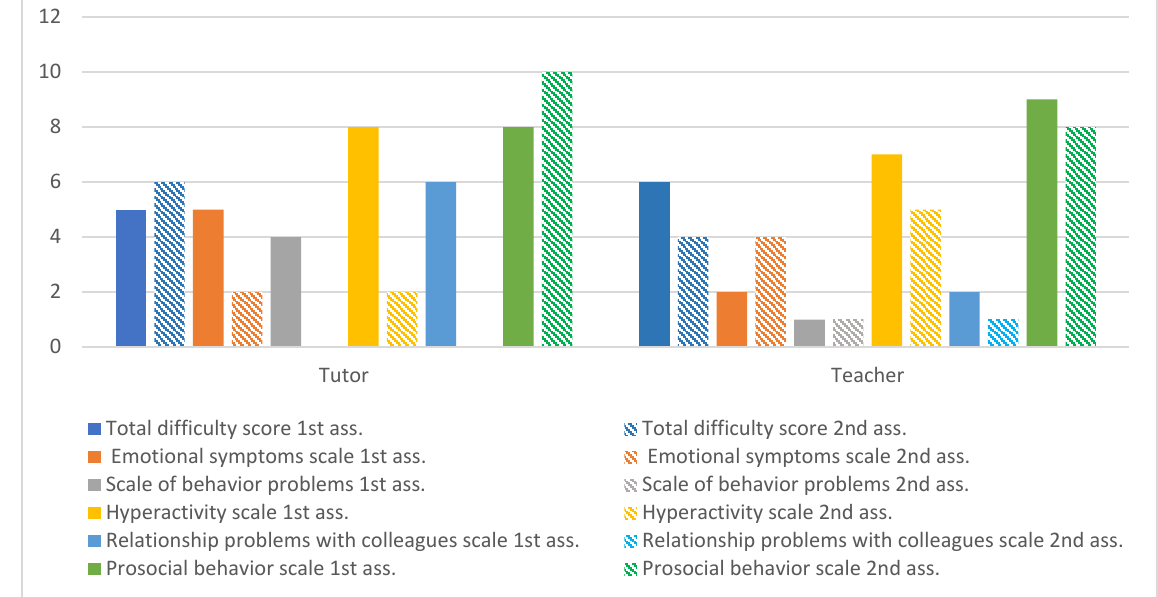
Figure 4. Tomás’s global assessment of SDQ . Figure 4. Tom á s’s global assessment of